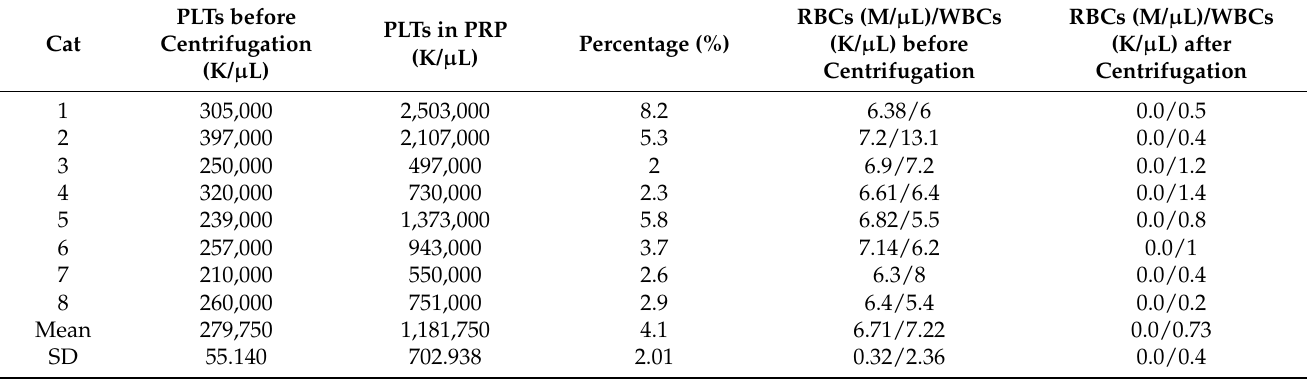
Table 2. Platelet concentration in PRP and in whole blood in the eight